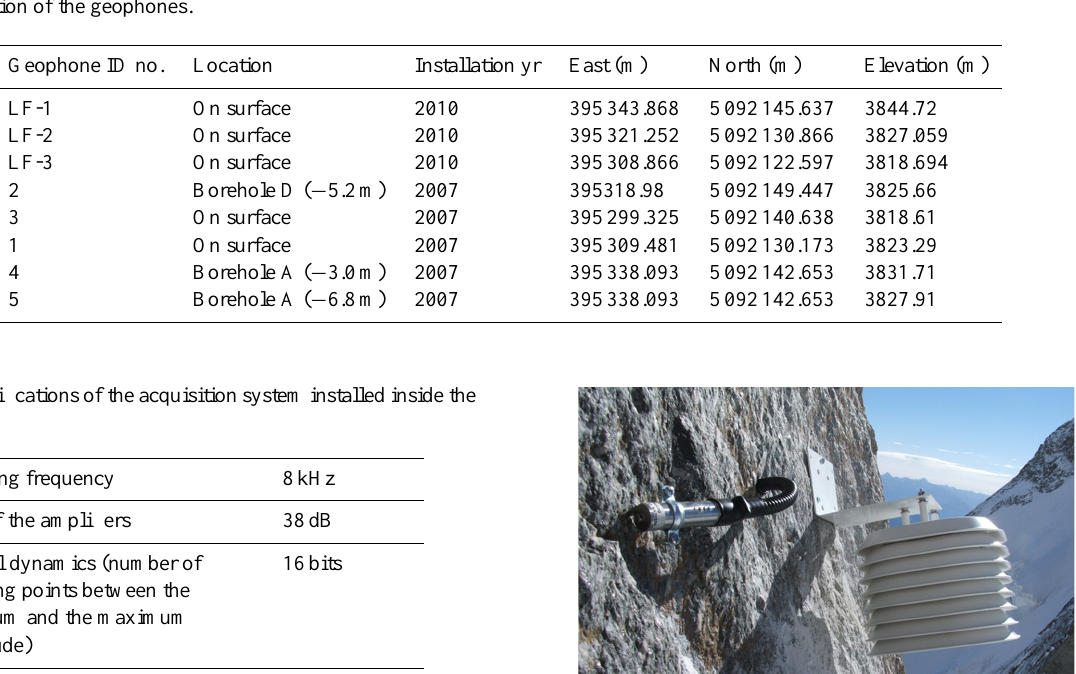
Table 2. Position of the geophones.